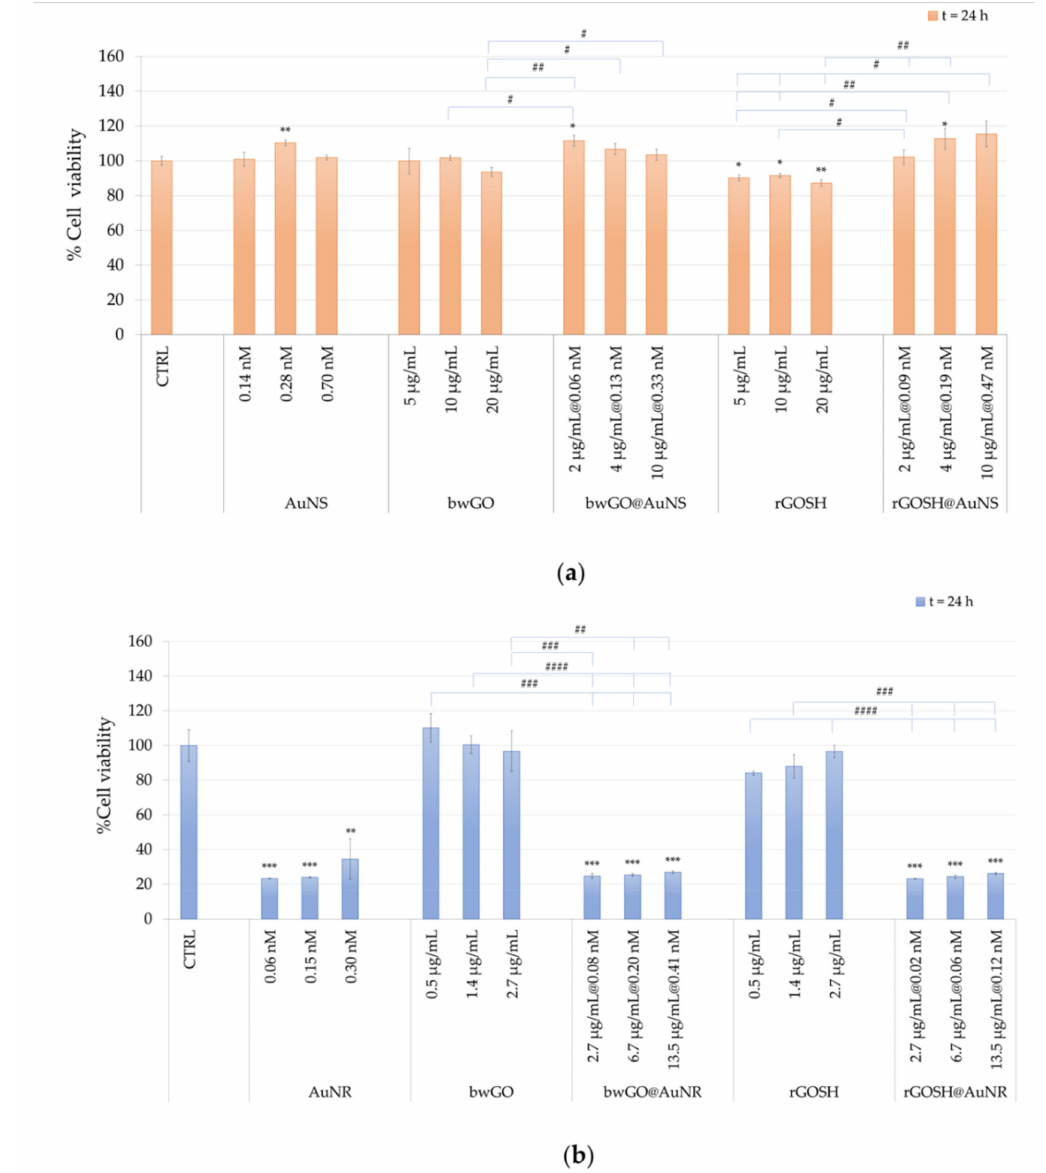
Figure 8. Cell viability of SH-SY5Y cells after 24-h incubation with the dispersion of gold nanospheres ( a ) or nanorods ( b ) as well as the corresponding nanocomposite with bwGO and rGOSH. The (*) p < 0.05, (**) p < 0.01 (***) p < 0.001, vs. untreated (CTRL), ( # ) p < 0.05, ( ## ) p < 0.01, ( ### ) p < 0.001, ( #### ) p < 0.0001 vs. bwGO and rGOSH (student’s